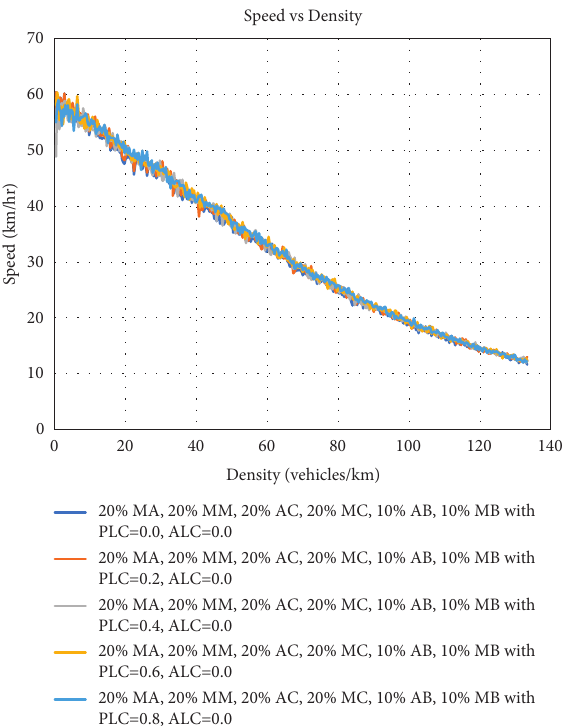
Figure 6: Speed vs. density fundamental diagrams for different compositions of MA, MM, AC, MC, AB, and MB with different values of PLC when ALC is fixed at 0.